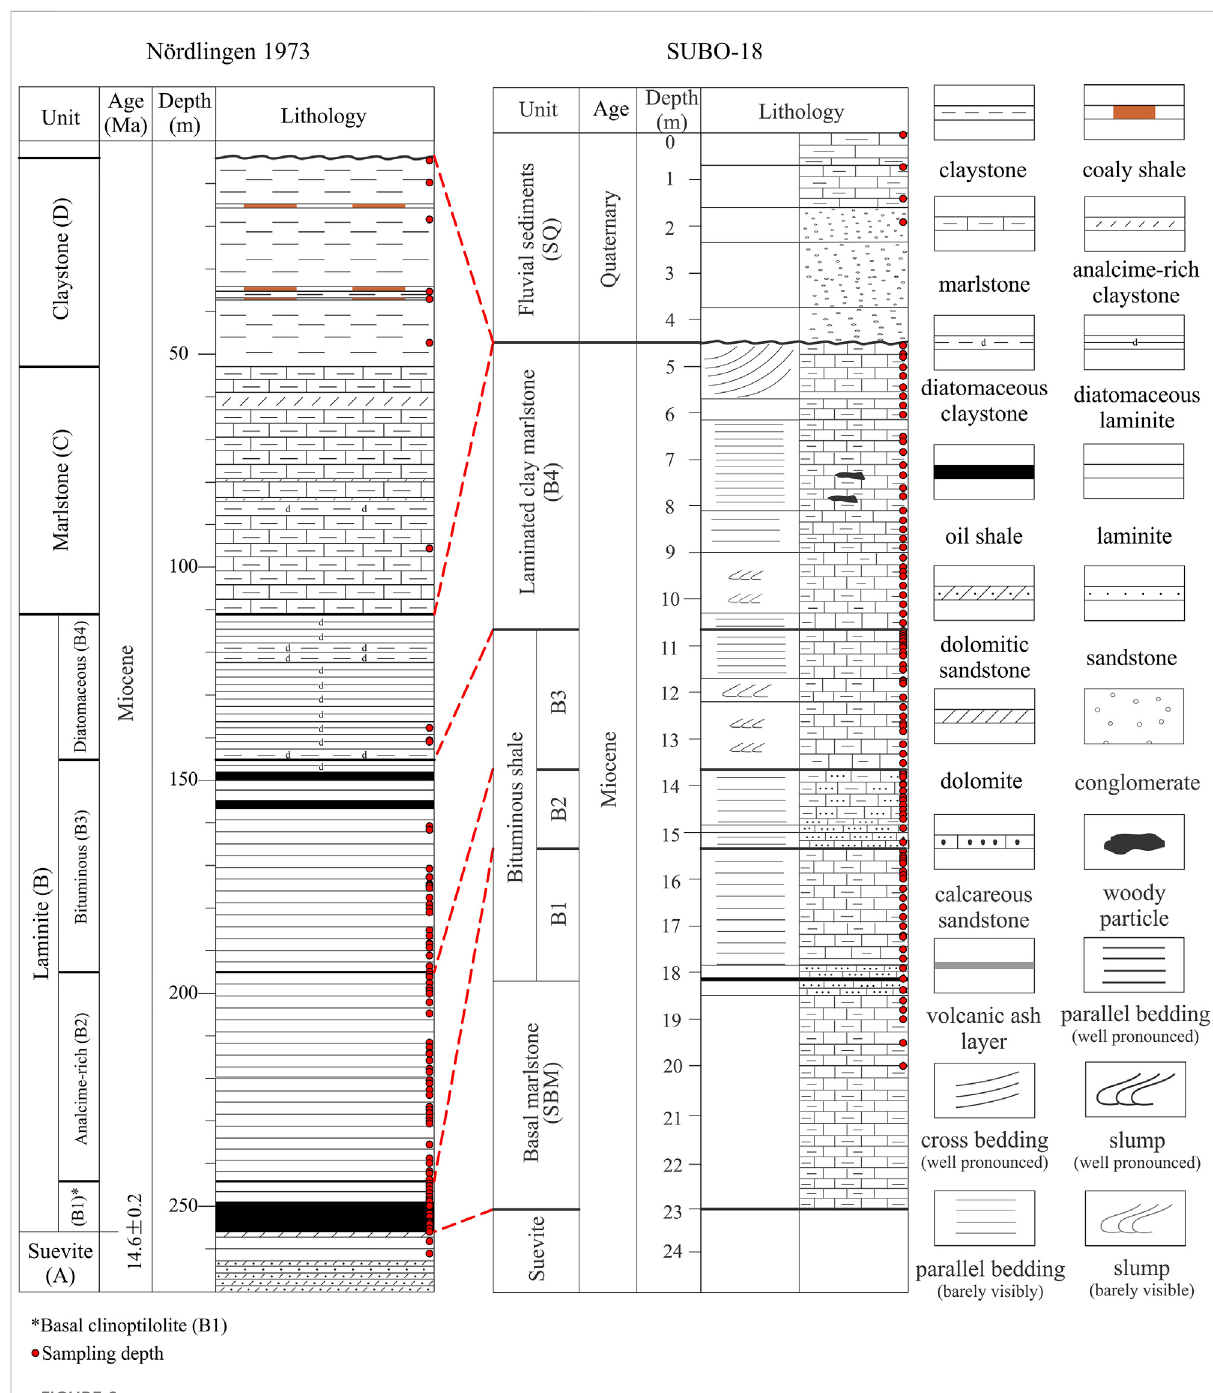
FIGURE 2 Lithological columns of the studied Nördlinger Ries boreholes. The lithology of the central borehole Nördlingen 1973 is based on Füchtbauer and von der Brelie (1977) and Rullkötter et al. (1990), whereas the presented column of the marginal borehole SUBO-18 was partly newly logged by theauthors in thisstudy with the main lithology boundaries based on Arp et al. (2014). Units C and D are missing in borehole SUBO-18. Note that the depth scale is different for both